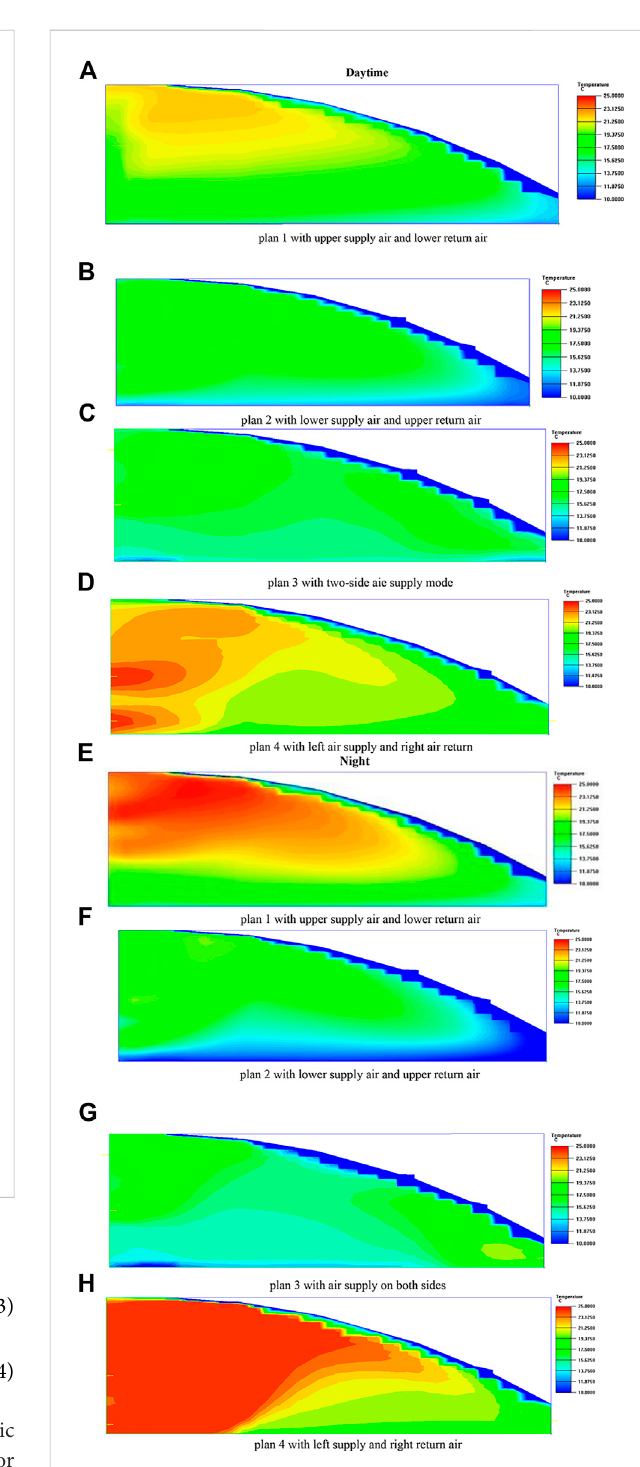
FIGURE 7 Temperature distribution diagram of typical longitudinal section.